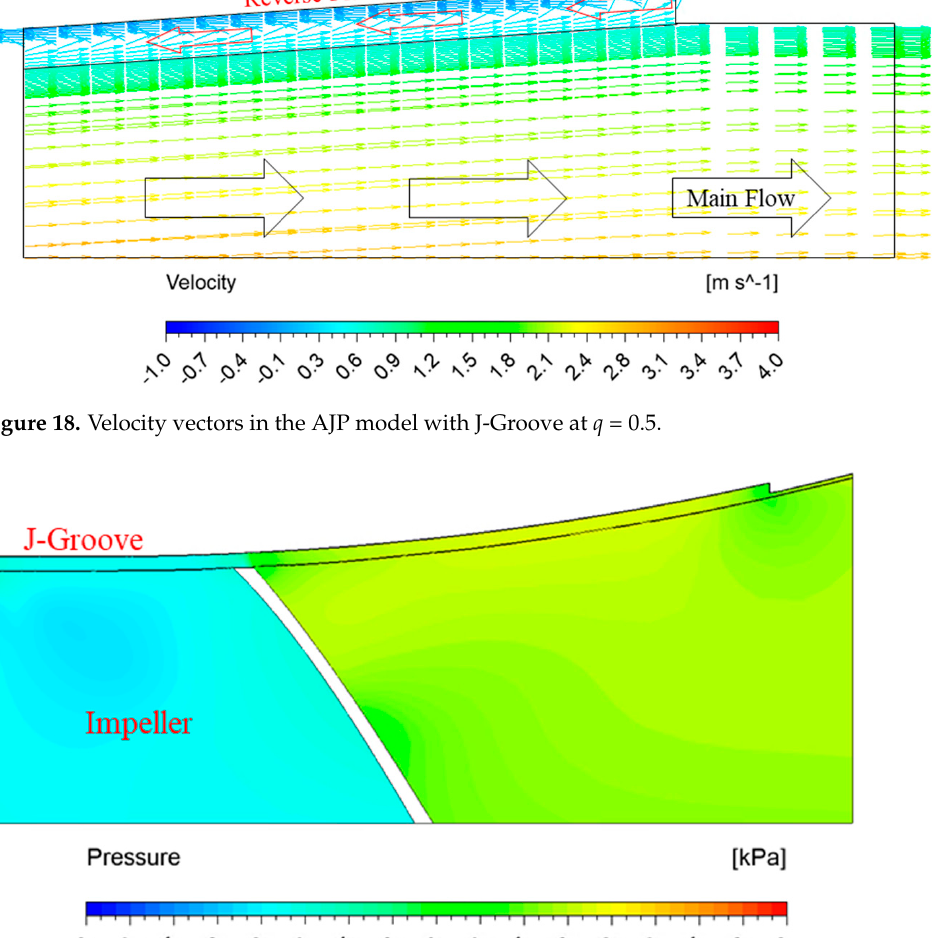
Figure 17. Pressure contours in the AJP model with J-Groove at q = 0.5.